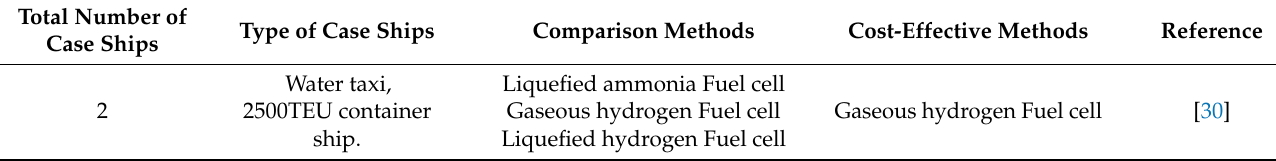
Table 3. Comparison between performed LCCA